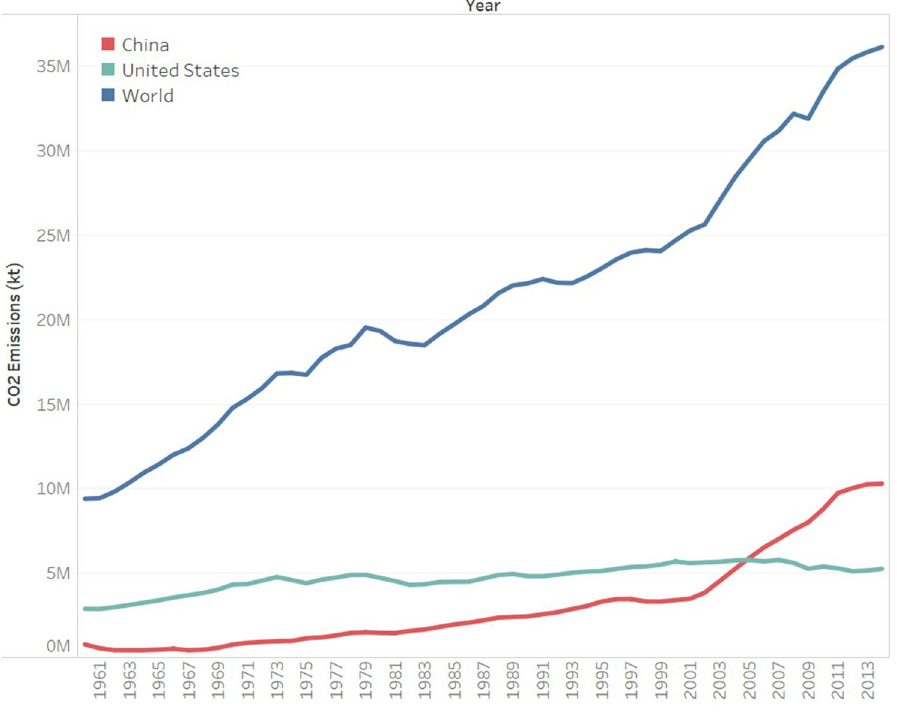
Figure 1. CO 2 emissions across the globe and, in China, and the United